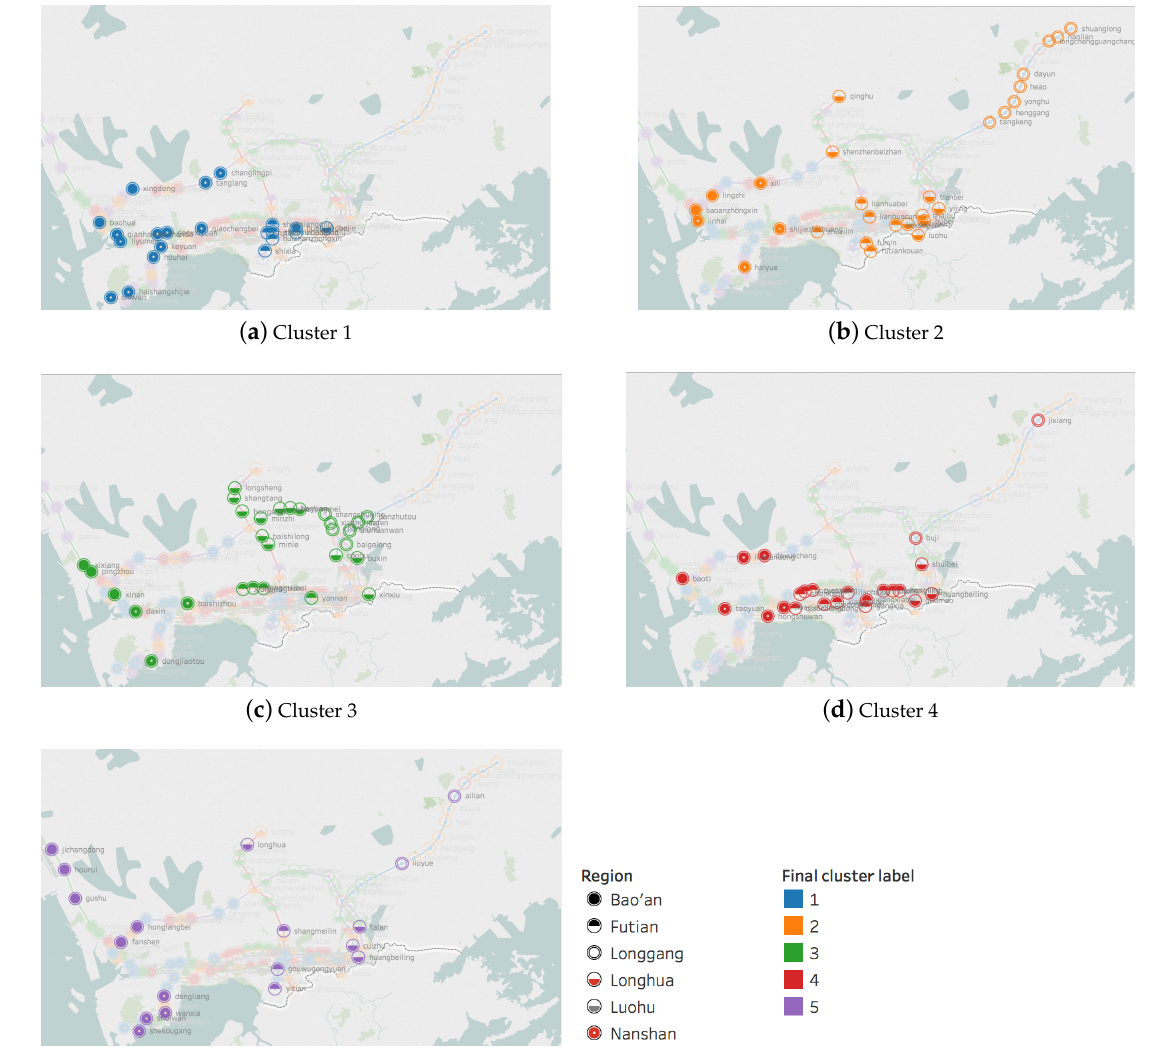
Figure 8. Map-based visualization of station clusters. The marks are labeled by station names, shape shows details about administrative region, and color of stations shows final cluster labels produced by proposed method. The maps are plotted using Tableau